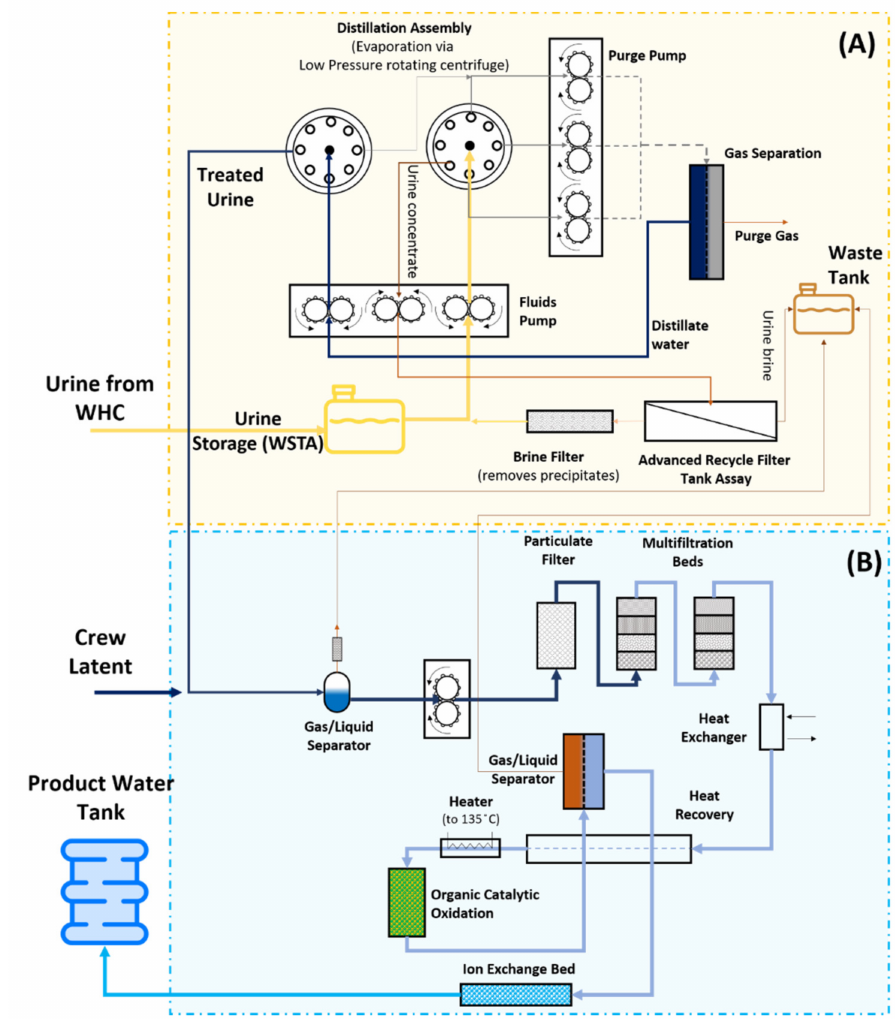
Figure 3. Schematic of the Urine Processor Assembly (UPA) ( A ) and the Water Processor Assembly (WPA) ( B ) installed at the ISS. Adapted and modified from